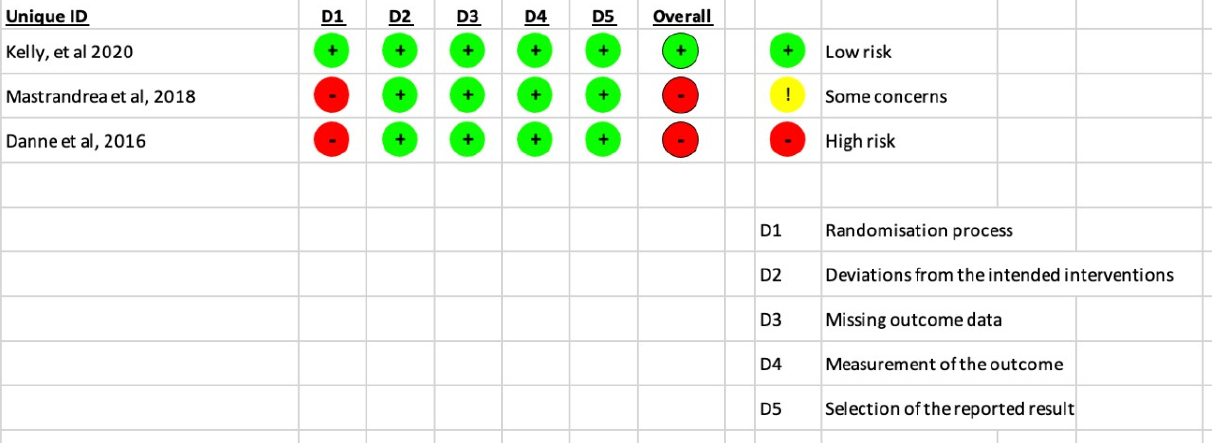
Figure 2. Results of the risk of bias analysis for the included RCTs [5,30,31].